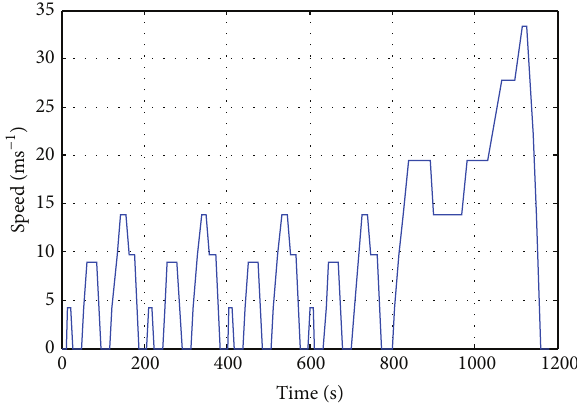
Figure 6: Driving pattern of